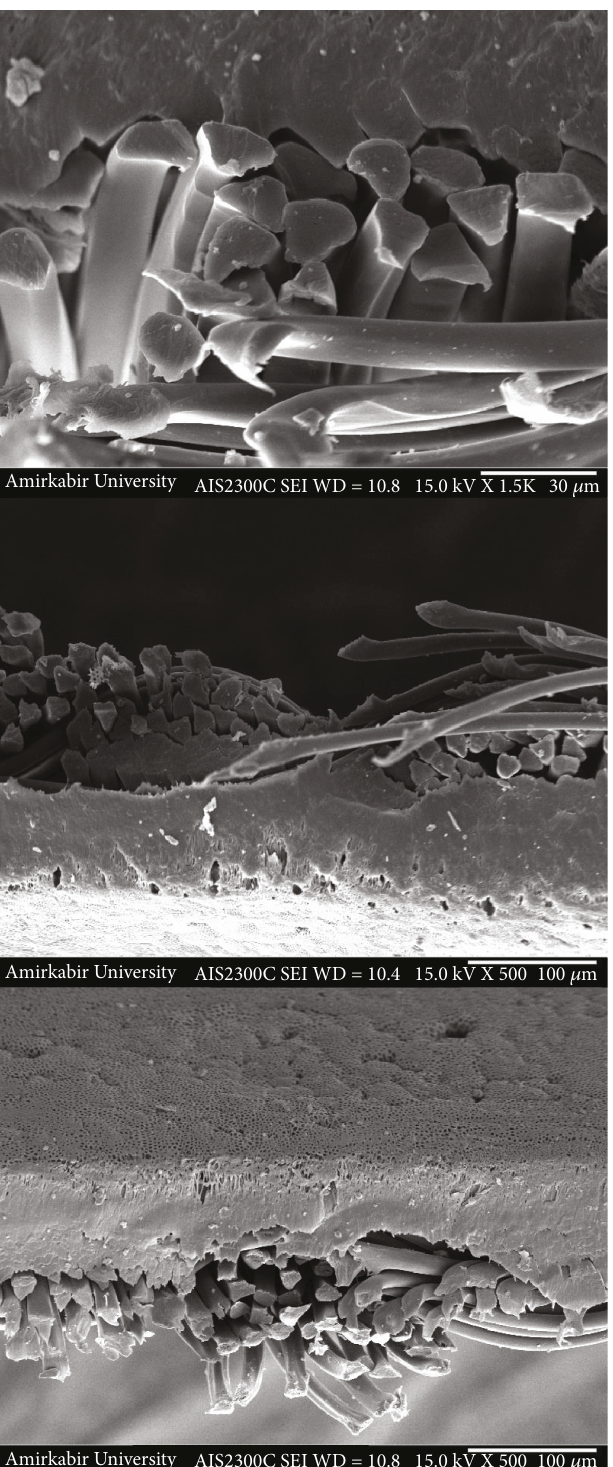
Figure 4: Selected cross-sectional SEM micrographs of the composite 60-7-20-13. Strong adhesion is seen between the coating (the top fi lm) and the fi bers from the fabric. The fi brils of the fi ber closer to the coating are fused to each